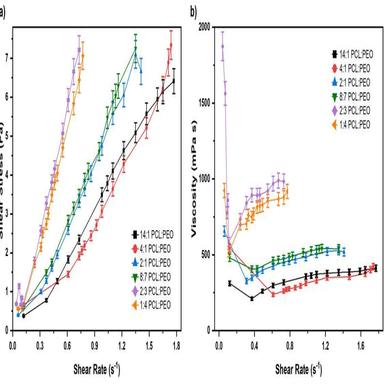
Graphs showing a) shear rate vs shear stress for the PCL:PEO binary polymer system at ratios 14:1–1:4, and b) viscosity vs shear rate for the PCL:PEO binary polymer system at ratios 14:1–1:4.